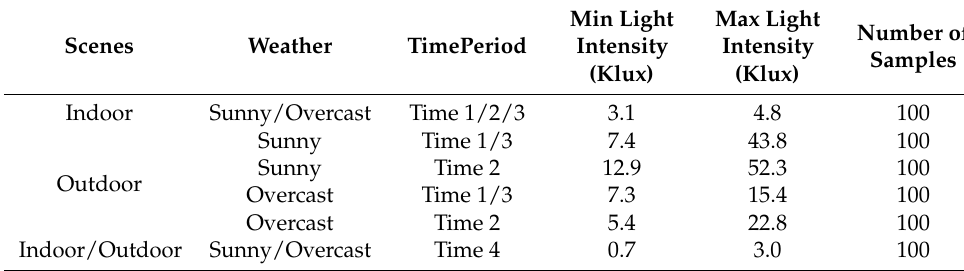
Table 1. Data information in the search phase.